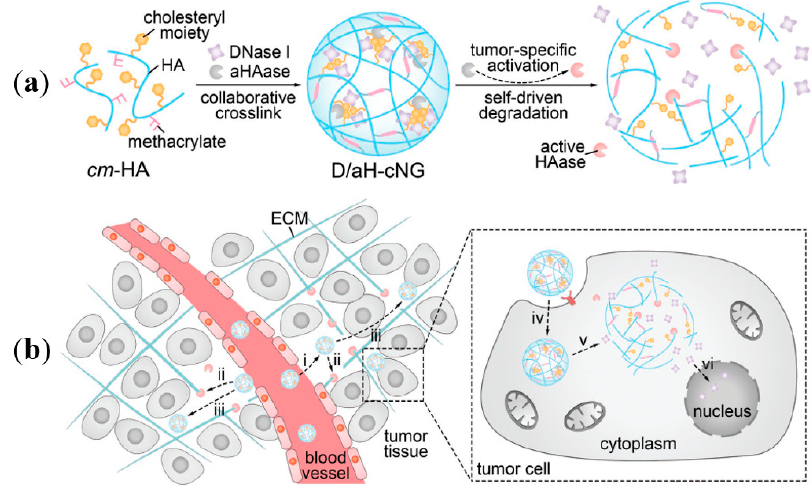
Figure 6. ( a ) Schematic of self-assembly and tumor-specific self-degradation of the collaboratively crosslinked nanogels (cNG). ( b ) Schematic of enhanced protein delivery by the cNG for cancer therapy. Modified from [84].